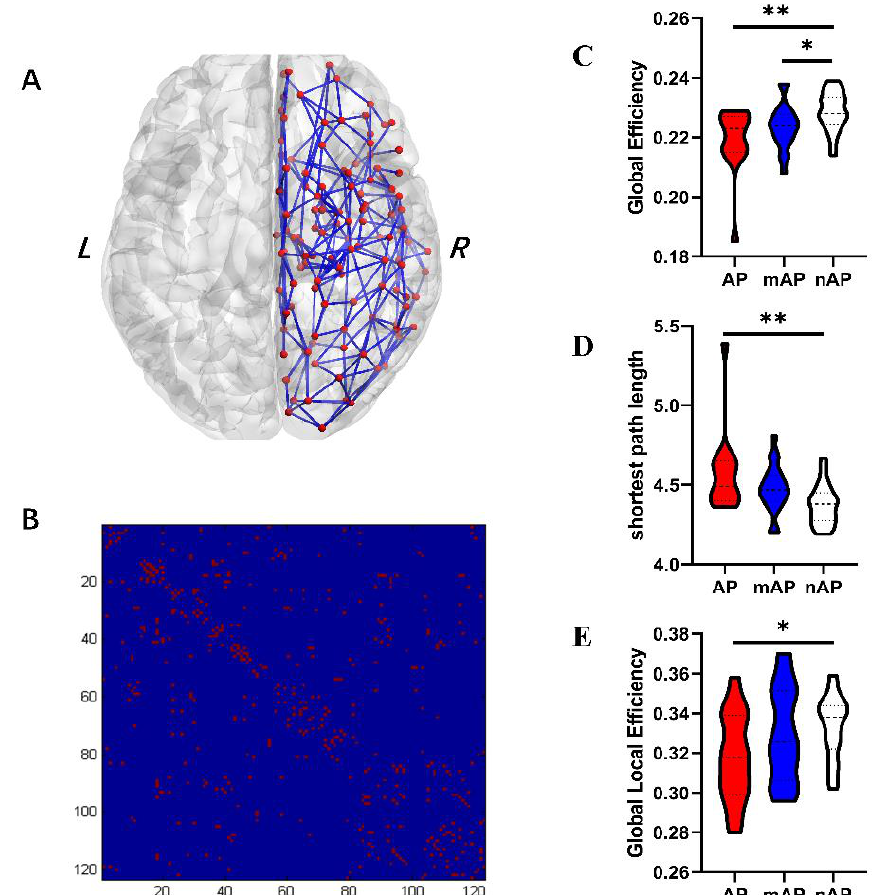
Figure 2. ( A ): All contralesional nodes and white matter connections identified by deterministic fiber tracking with the backbone method. ( B ): Binarized connectome matrix of the contralesional hemisphere. ( C – E ): Violin figures of global topological properties with group differences. (*, p < 0.05; **, p < 0.01).